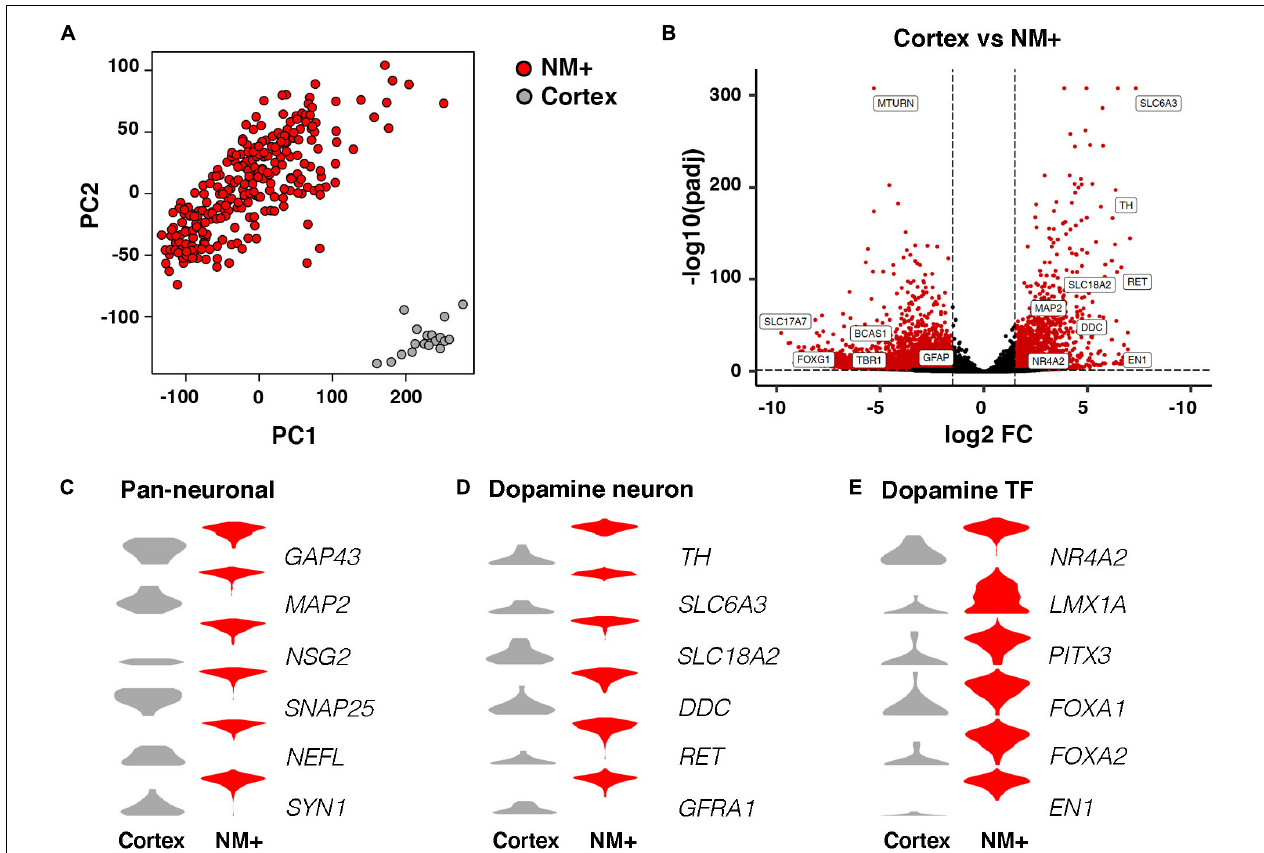
FIGURE 2 | RNA-seq analysis of neuromelanin positive cells in comparison to cortex. (A) Two dimensional PCA (PC1, PC2) of NM+ neurons (252 samples) and cortical neurons (18 samples). Samples are color-coded by cell type. (B) Volcano plot showing fold changes of individual genes in the DESeq2 analysis. Red: higher expression in NM+ samples (right side of the plot) or cortex samples (left side of the plot), (padj < 0.05, RPKM > 1, fold change > 1.5), Black: no significant difference. (C–E) Expression level per cell type for indicated genes in log 2 (RPKM+1) in y-axes. Genes represent markers for pan-neuronal cells (C) , dopamine neuron (D) , and dopamine transcription factors (E)